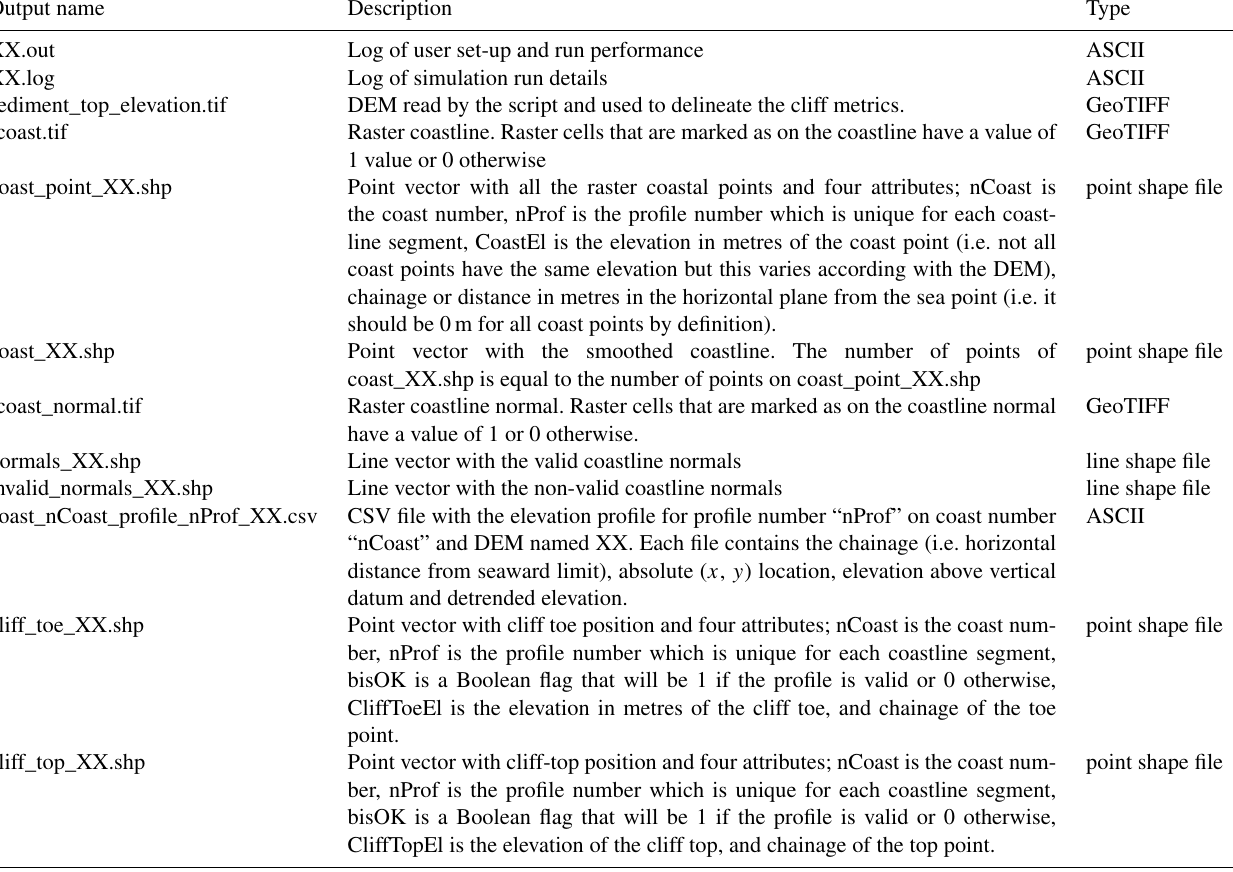
Table 1. Summary of output files produced by the proposed method: name, description and type.